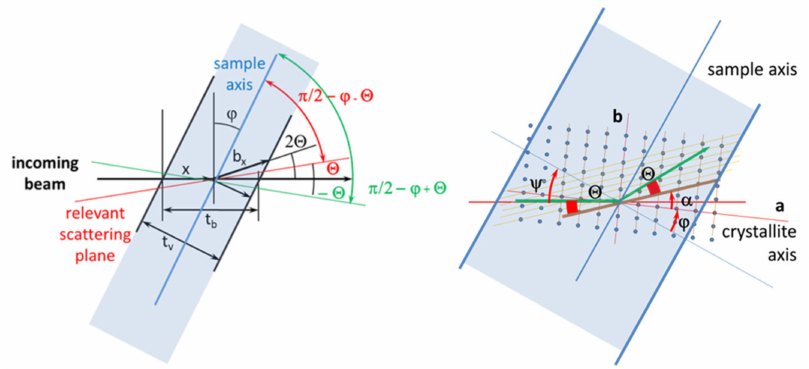
Figure 4. Detailed scattering geometry (here for the reflection (1 2 0): The sample is rotated by an angle ψ to the beam, the a-axis of an individual crystallite has an angle of ϕ within the sample, the scattering crystalline plane has an angle of α to the a-axis. The scattering angle Θ is between the incoming beam and the scattering plane as well as between this and the scattered